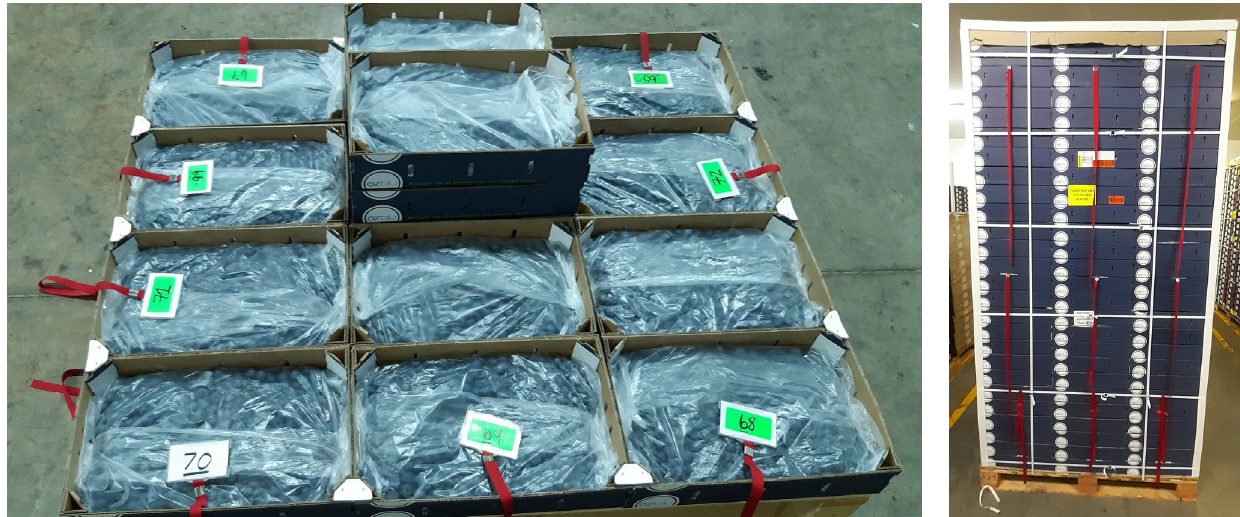
Figure 4. iButtons ® placed in cartons during building of pallets at the packhouse . Source: [13].